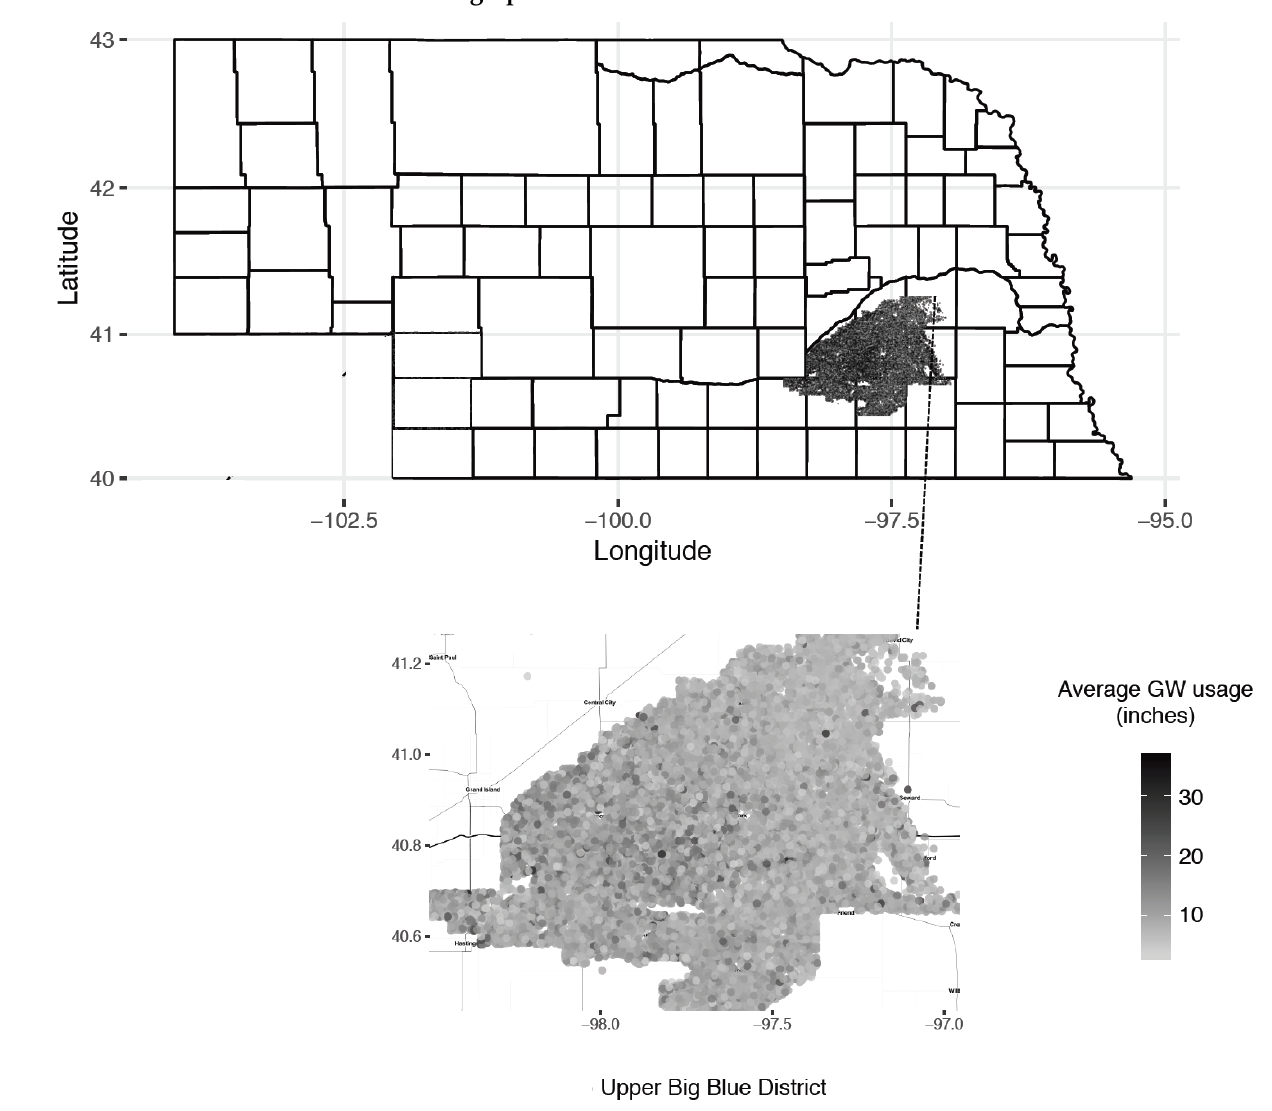
Figure 1. Average water-per-acre usage in the Upper Big Blue District from 2007–2014. One inch = one inch of groundwater on top of one acre of land, which is 27,157 gallons.